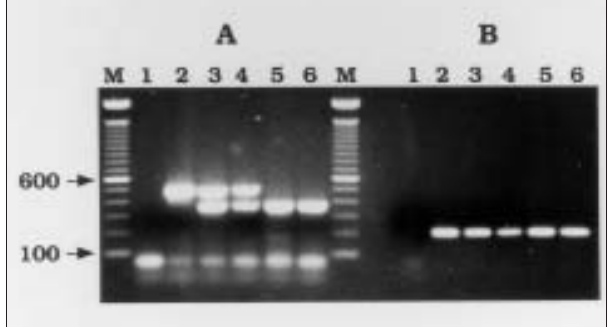
Figure 2) Polymerase chain reaction amplification from Mycobacte- rium tuberculosis strains. Reaction products were electrophoresed on a 1.5% agarose gel stained with ethidium bromide. Panel A amplifica- tion using primers to IS 6110 and mpcA ; Panel B amplification using primers to the 16S/23S rRNA gene spacer. Lane 1, water control; lane 2, S384; lanes 3 and 4, clinical isolates of M tuberculosis ; lane 5, My- cobacterium bovis bacillus Calmete-Guérin (BCG) (ATCC 35732); lane 6, M bovis ; lane M, 100 basepair (bp) ladder (Gibco-BRL). Arrows indi- cate sizes of molecular weight markers in bp